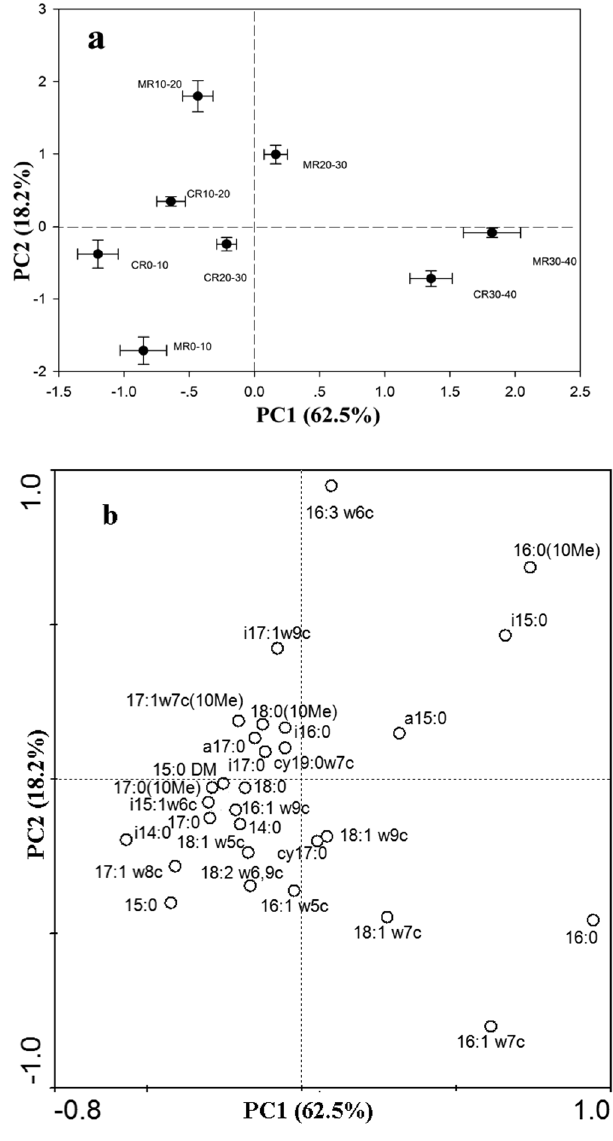
Figure 2. Principal components analysis of phospholipid fatty acid (PLFA) profiles ( a ) and loading values for individual PLFAs ( b ). CR 0–10, CR 10–20, CR 20–30, and CR 30–40 indicate 0–10 cm, 10–20 cm, 20–30